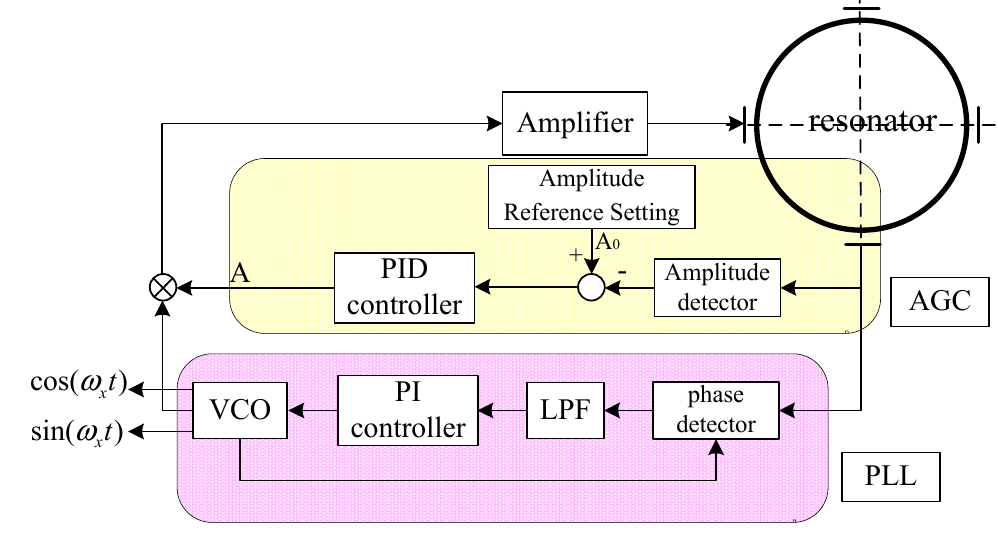
Figure 3. Primary control loops of the HRG including Phase-lock Loop (PLL) and Automatic Gain Control Loop